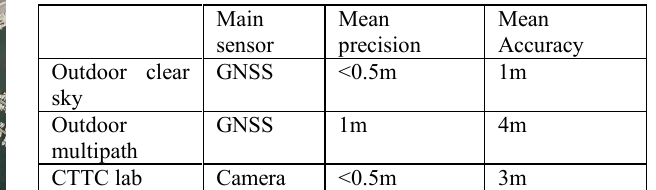
Figure 9 . Estimated “CTTC-LAB” trajectory. Green dots indicate positions provided by the GNSS while red dots are the ones provided by camera-based tracking system.